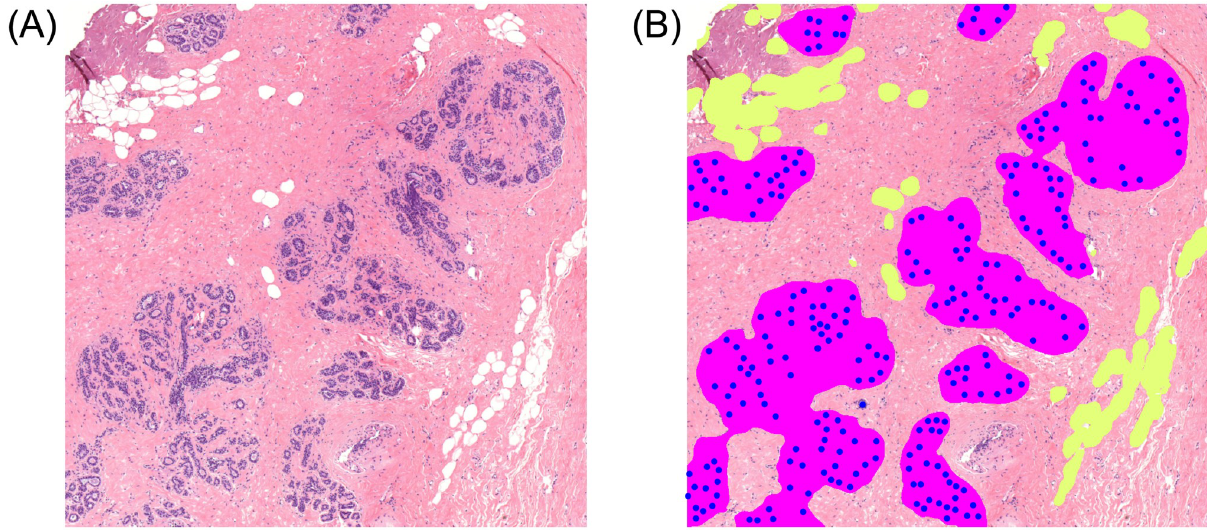
Fig 3. Results of the acini detection, terminal duct lobular unit, and adipose tissue segmentation algorithms (B) overlaid on the original image (A).